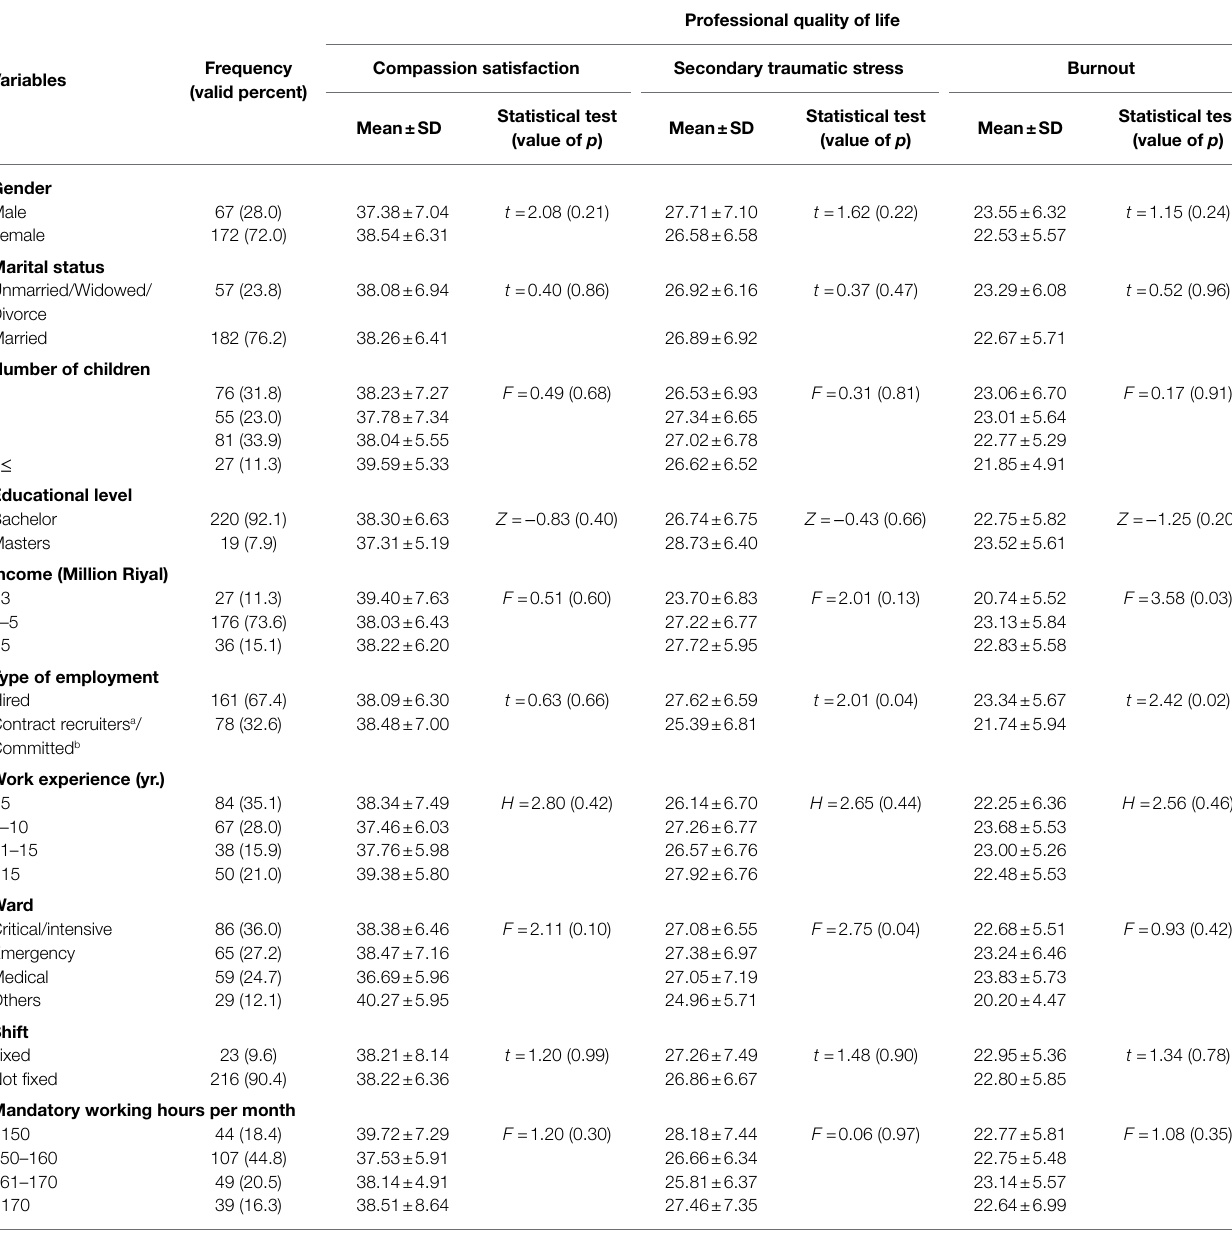
TABLE 1 | Demographic characteristics of the participants and their associations with Professional quality of life ( n =